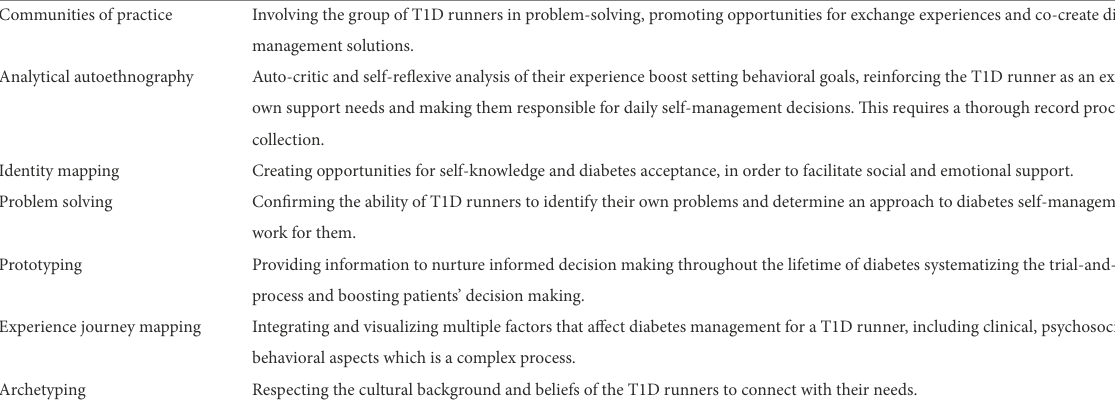
TABLE 2 Design recommendation to encourage self-management for T1D